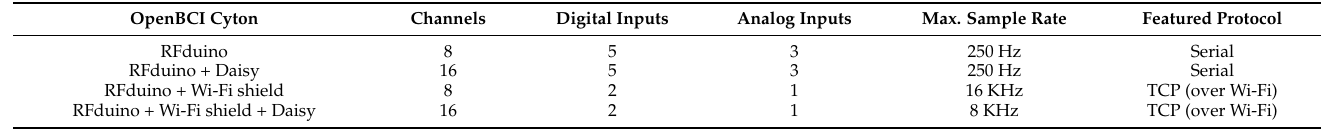
Figure 4. Composition of the data block throughout the distributed data acquisition and processing system,.